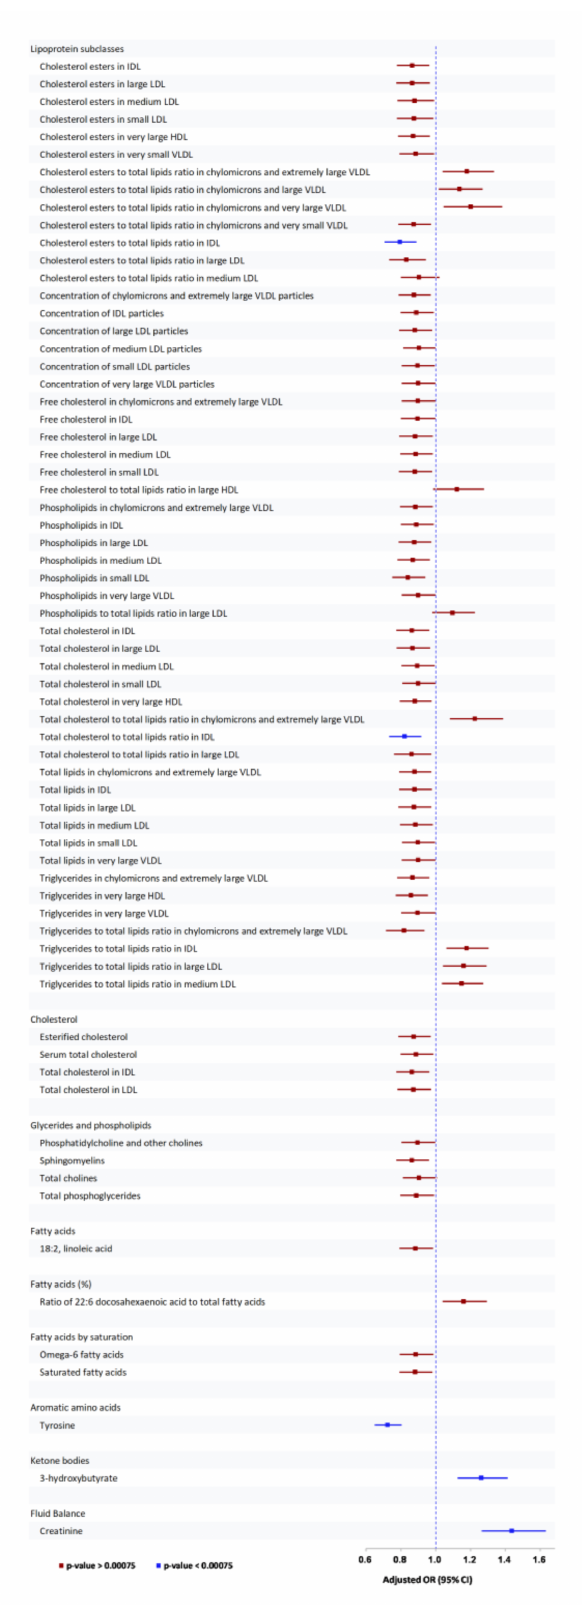
Figure 1. Association between serum/plasma metabolites and any DR in Chinese, Indians, and Malay cohorts. OR estimate corresponds to per SD ↑ in serum metabolites; OR estimates adjusted for age, sex, systolic BP, duration of diabetes, and